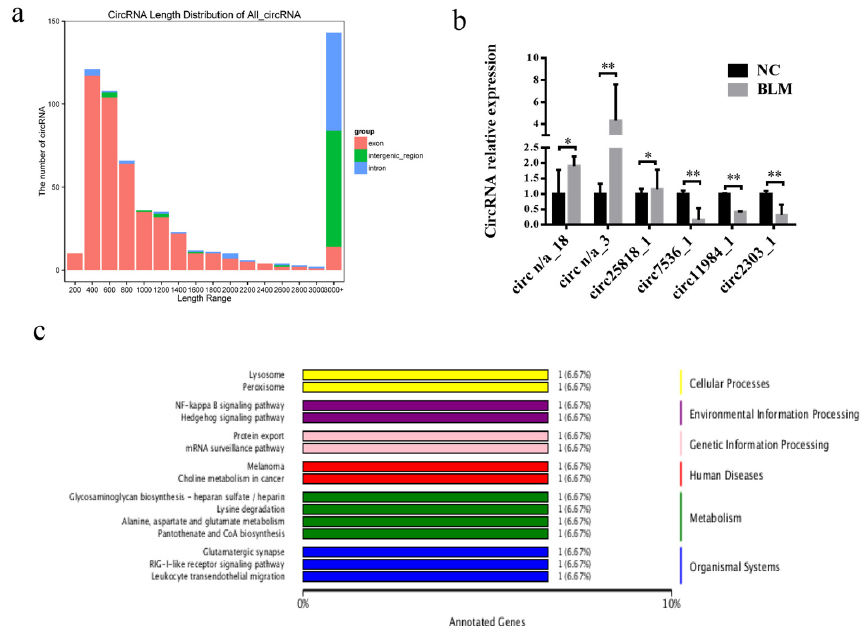
Figure 5. Identification of differentially expressed circRNAs. ( a ) CircRNA length and derivation analysis. ( b ) Expression of up- and downregulated circRNAs in the NC and BLM groups, as deter- mined by RT–PCR. ( c ) KEGG pathway of differentially expressed circRNAs. Significant differences are represented with *( p < 0.05) and **( p < 0.01).